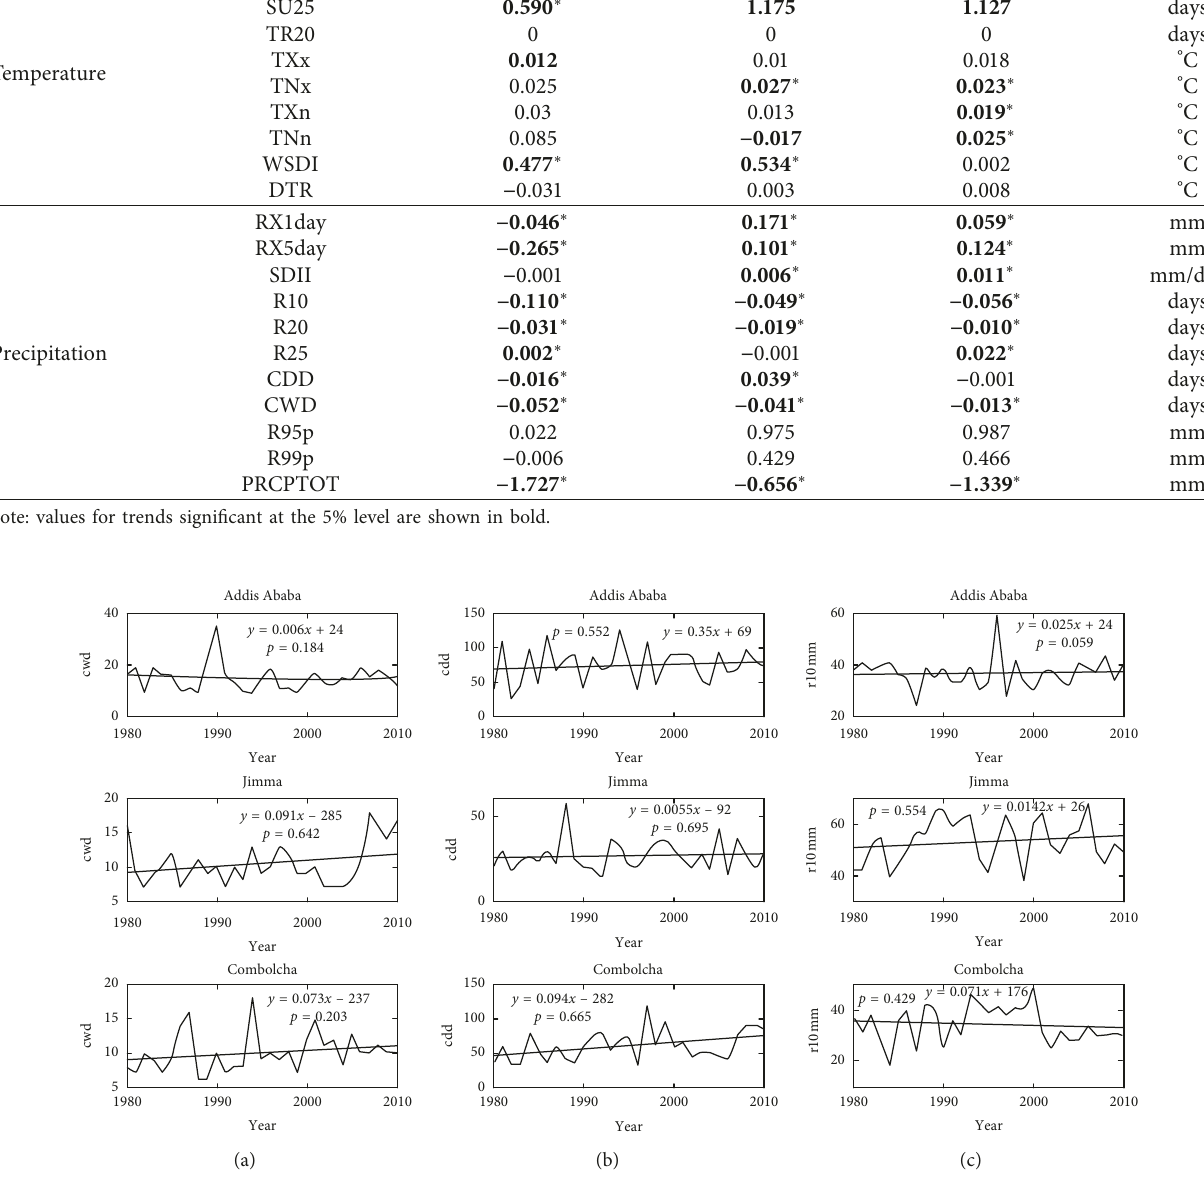
Figure 5: Time-series plot of consecutive wet days (a), consecutive dry days (b), and the number of heavy precipitation days at 10mm (c).